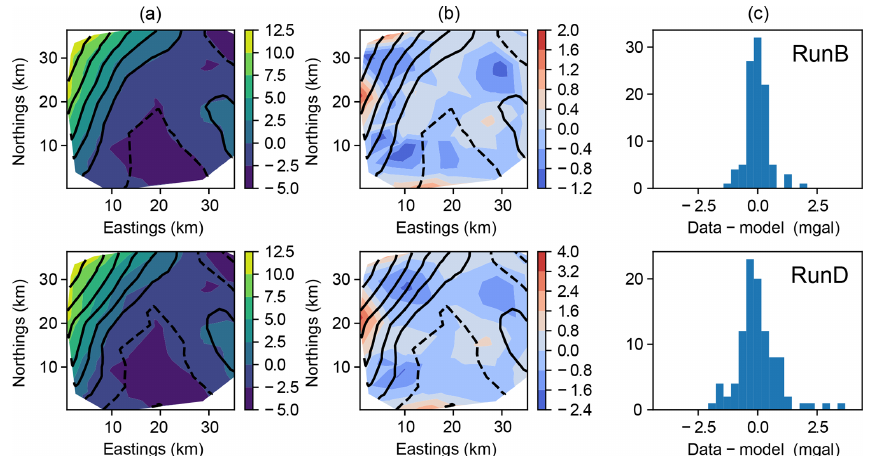
Figure 5. Gravity anomaly at the surface ( z = 0). In a contour plot (a) , filled contours are observations, and black lines represent mean posterior forward model prediction. Residuals of observations from the mean posterior forward model are also shown as a contour map (b) and histogram (c)